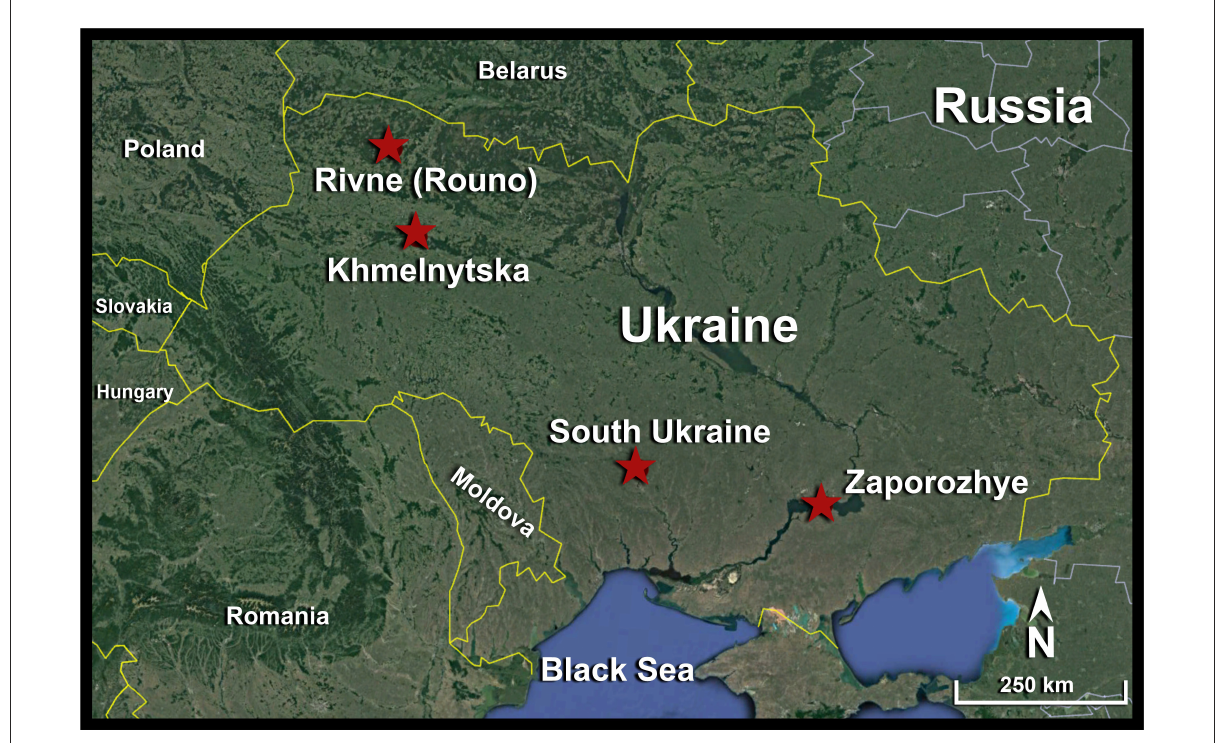
FIGURE1 Locations of the Ukrainian nuclear power plants. Base map is from Google Earth.